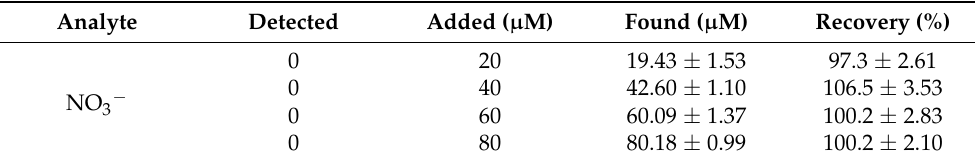
Table 3. Recovery results of NO 3 − detection in the tap water